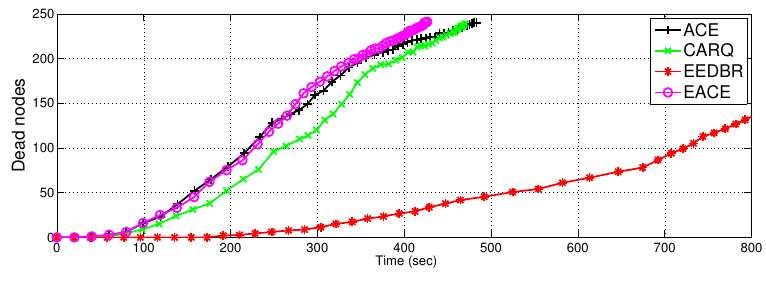
Figure 8. Network